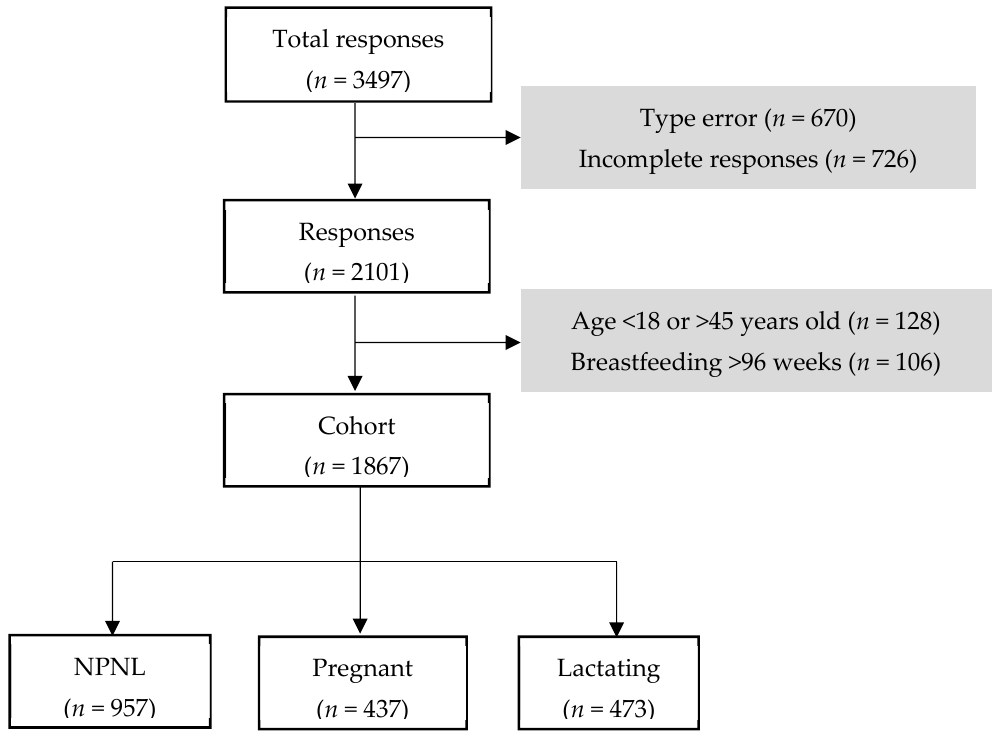
Figure 1. Flowchart diagram of enrollment. NPNL = non-pregnant/non-lactating women, n = sample size.